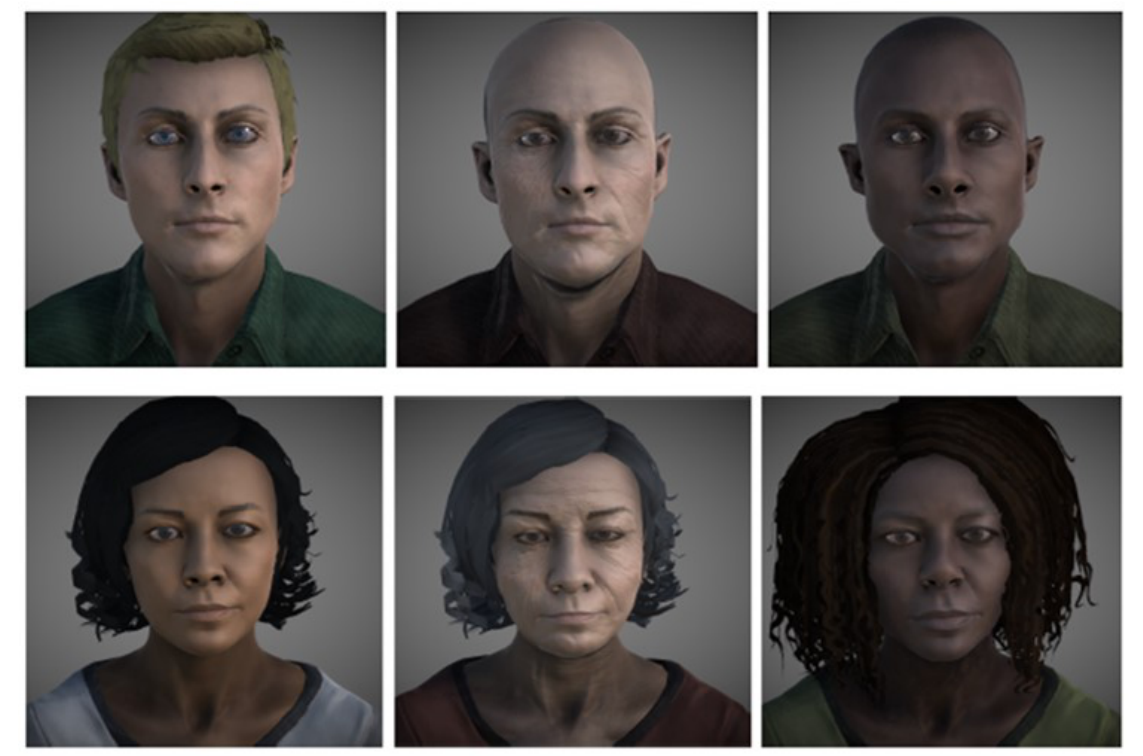
Figure 1. Examples of virtual